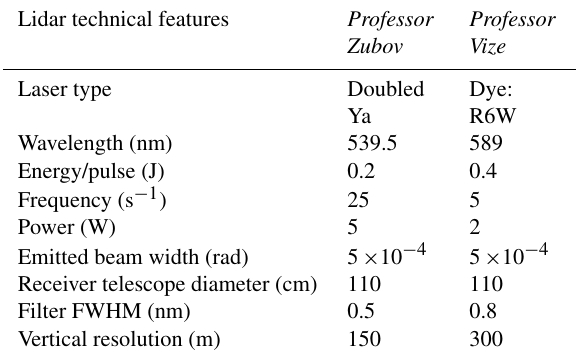
Table 1. Technical features of the two shipborne lidars. Ya: yttrium aluminium. From Table 1 of Avdyushin et al. (1993). Lidar technical